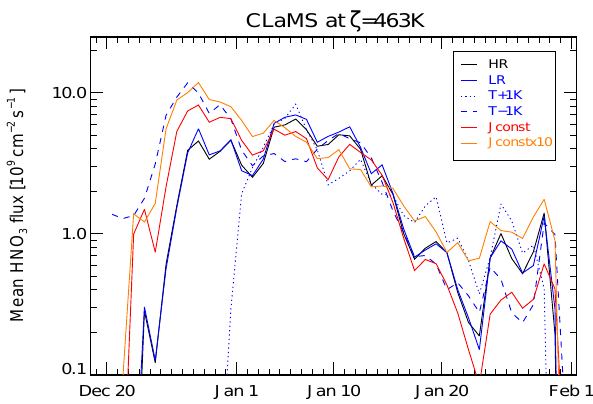
Fig. 11. Simulated NO y redistribution profiles averaged inside the polar vortex core (equivalent latitudes > 70 ◦ N) for 15 January and 10 March. Shown are the results for the different sensitivity sim- ulations as indicated in the legend. Simulation S64 that is almost identical with LR is